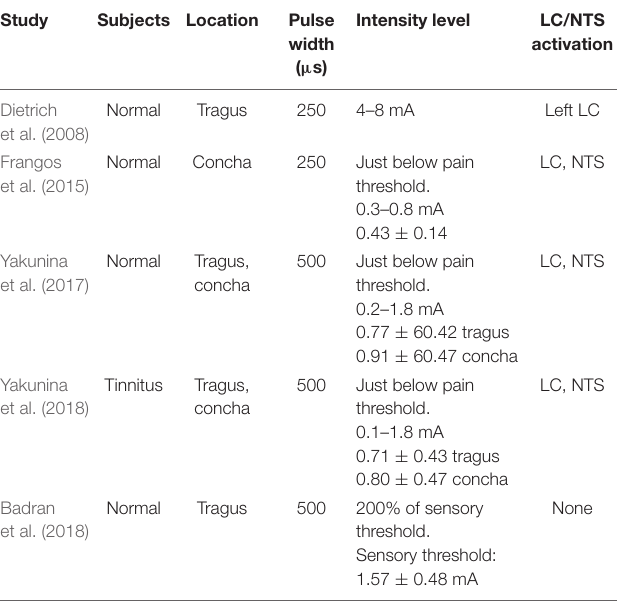
TABLE 1 | Parameters used in the tVNS fMRI